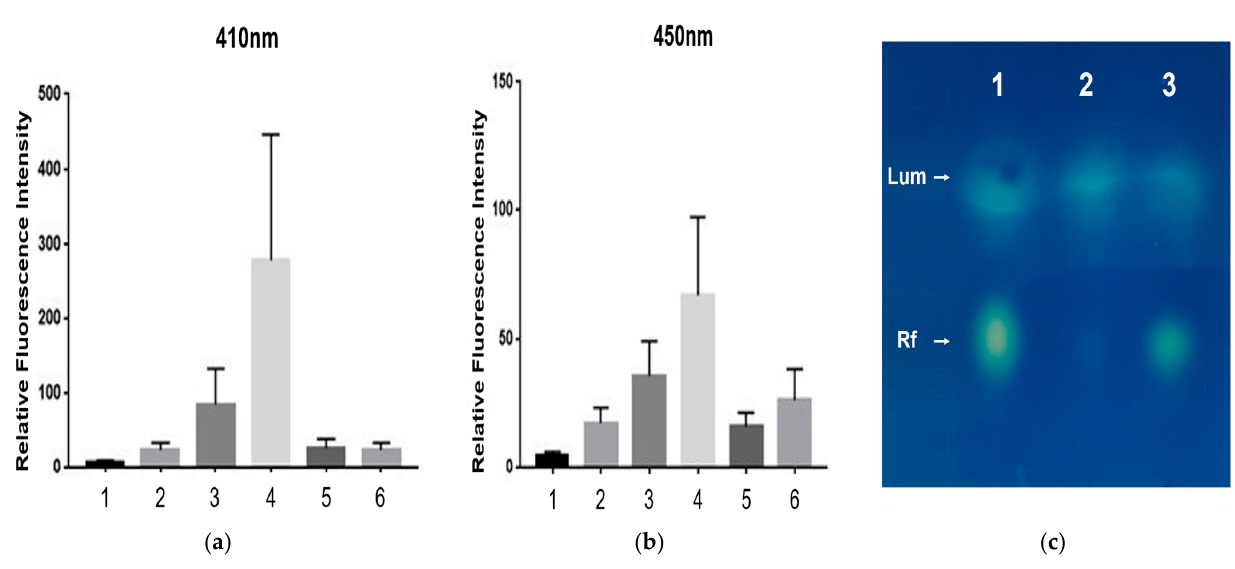
Figure 9. Relative fluorescence intensities. 1, E. coli 43R itself; 2, pRFN4 in E. coli 43R; 3, pRFN4-Pp N- lum P in E. coli 43R, 4, pRFN4-Pp lux LP-N- lum P in E. coli 43R; 5, pRFN4-Pp lux CP-N- lum P in E. coli 43R; 6, pRFN4-Pp lux CP in E. coli 43R. ( a ) Excitation wavelength was fixed at 410 nm for lumazine. ( b ) Excitation wavelength was fixed at 450 nm for riboflavin. ( c ) Identification of lumazine and riboflavin in TLC (thin layer chromatography) panel under UV illumination. 1, Mixtures of lumazine and riboflavin; 2, cell free extract of pRFN4 in E. coli 43R; 3, cell free extract of pRFN4-Pp lux LP-N- lum P in E. coli 43R. Lum, lumazine; Rf, riboflavin.